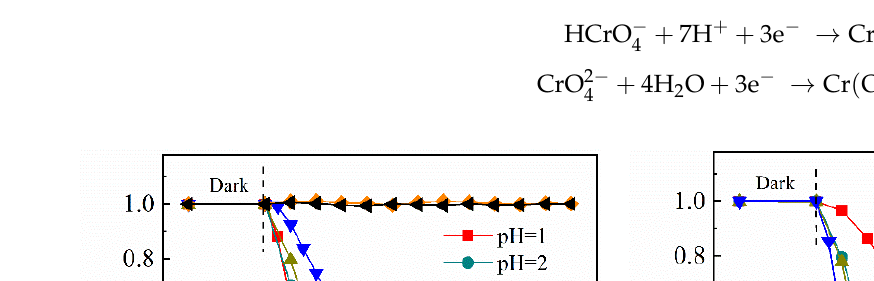
8 of 15 Figure 5. ( a ) Effect of materials on the photocatalytic activity of g-C 3 N 4 , ( b ) Photodegradation kinetic constants of g-C 3 N 4 prepared from different materials, ( c ) Correlation of C/C 0 and specific surface area (S BET ), ( d ) Correlation of N content and normalized C/C 0 (k/S BET ). (Experimental conditions: initial Cr(VI) concentration = 50 mg L − 1 ; catalyst amount = 50 mg; reaction volume = 150 mL; citric acid = 0.9 Mm; pH = 3; white light irrigation). Figure 6a depicts the effect of initial pH of the solution on Cr(VI) reduction over U- CN. The photocatalytic reduction efficiency of Cr(VI) decreases markedly with the in- crease of pH value. In addition, when pH is 7 or 9, Cr(VI) cannot be degraded at all. pH value affects the existence of Cr(VI) as well as the surface charge of g-C 3 N 4 . Cr(VI) is pre- sented as Cr 2 O 72 − , HCrO 4 − in acidic solution and mainly as CrO 42 − in basic solution [40]. The surface of the catalyst becomes highly protonated at low pH value, which makes the surface of the catalytic more conducive to the accumulation of HCrO 4 − . While the surface of g-C 3 N 4 is negatively charged at alkaline solution, which tends to repel the Cr 2 O 72 − . The Cr (VI) photoreduction was achieved following Equations (1) and (2) under acidic solu- tion, and the hydrogen ion was beneficial to the reduction reaction. In contrast, the Cr(VI) reduction under alkaline solution was accomplished following Equation (3) [41]. In addi- tion, Cr(OH) 3 may be formed under high pH value and covers the active sites of the pho- tocatalyst, leading to the declining Cr(VI) reduction performance [42]. Cr 2 O 72− + 14H + + 6e − → 2Cr 3+ +7H 2 O (1) HCr O 4− + 7H (cid:2878) + 3e (cid:2879) → Cr (cid:2871)(cid:2878) +4H (cid:2870) O (2) CrO (cid:2872)(cid:2870)(cid:2879) + 4H (cid:2870) O + 3e (cid:2879) → Cr(OH) (cid:2871) +5OH (cid:2879)